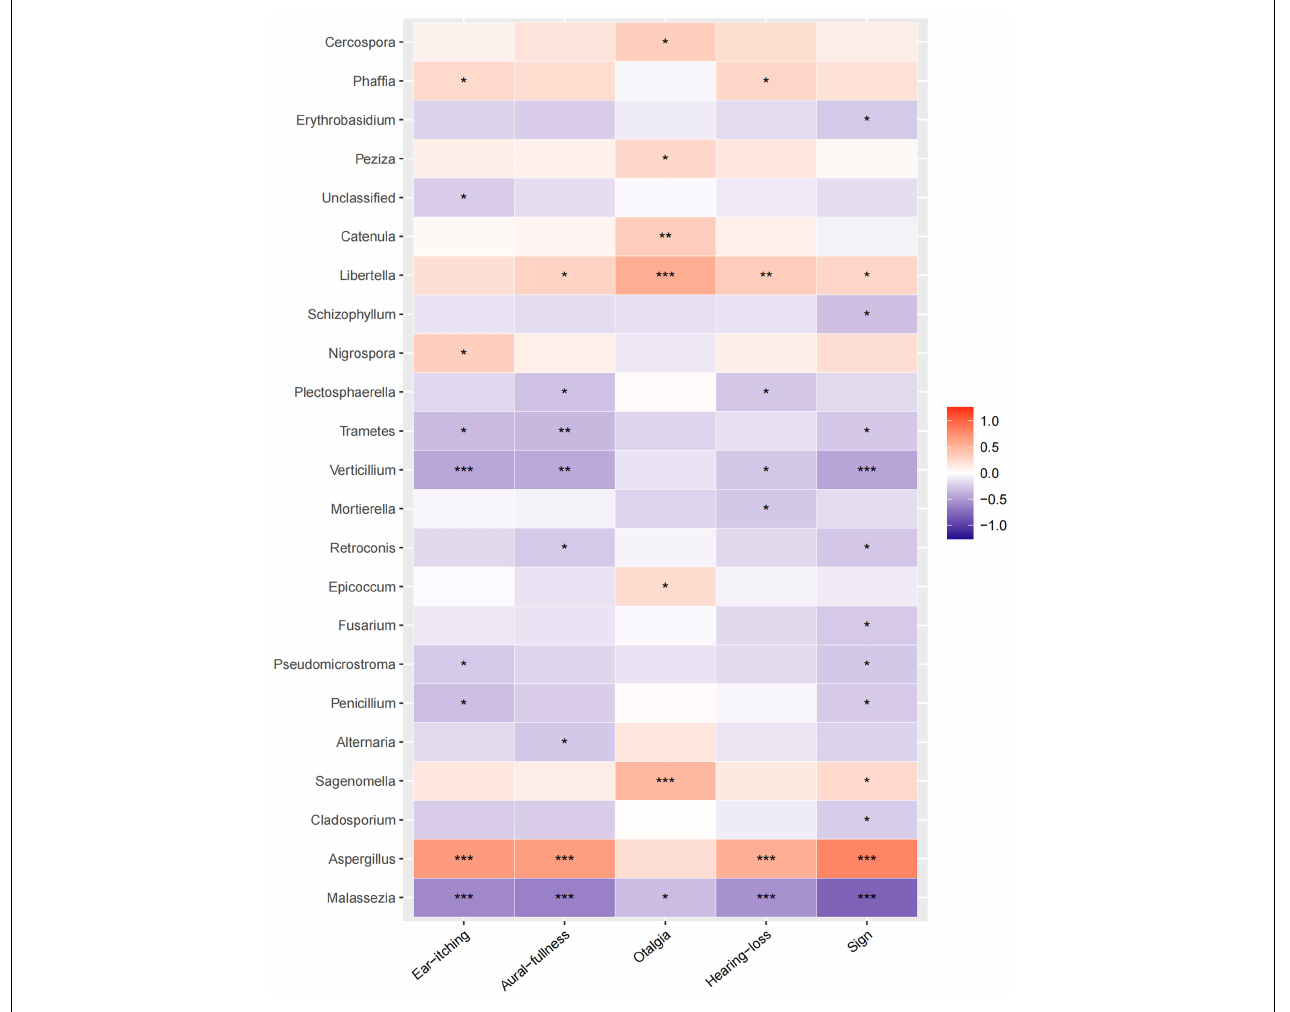
FIGURE 5 | Correlation analysis between fungal abundances and clinical factors. Relative heatmap analysis between fungal genera and clinical symptoms/signs. The colors range from blue (negative correlation) to red (positive correlation). Significant correlations are noted by ∗ p < 0.05, ∗∗ p < 0.01, and ∗∗∗ p <